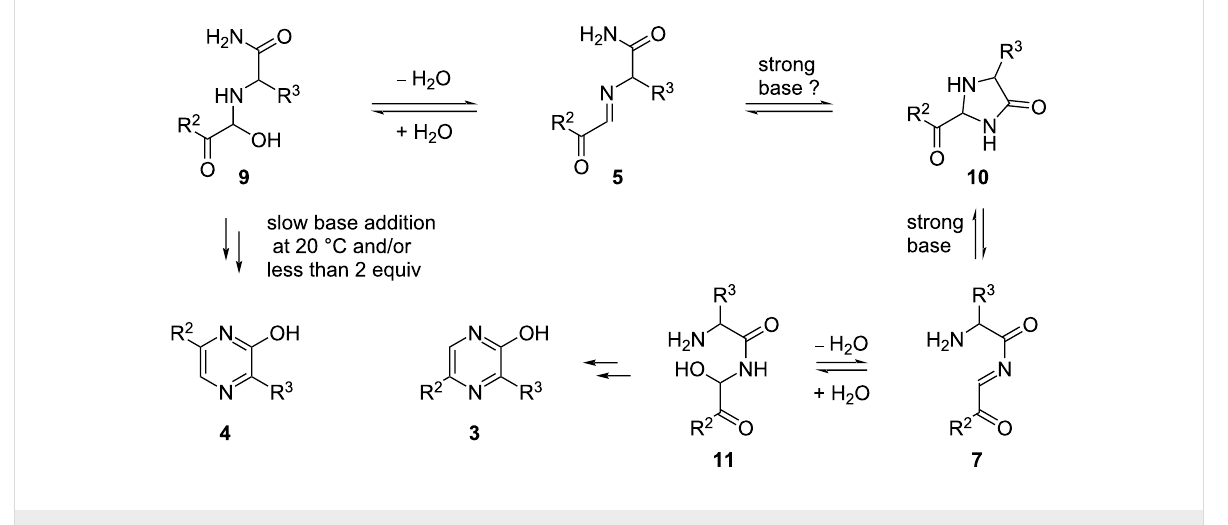
Scheme 3: Suggested mechanism for the Reuben G. Jones synthesis of